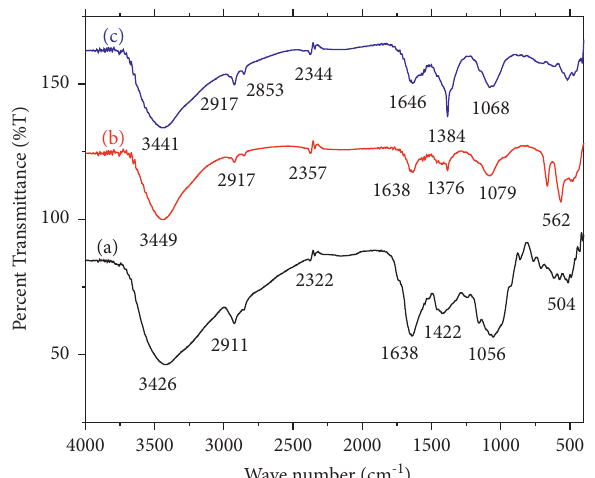
Figure 5: FTIR spectra of (a) calcined Co 3 O 4 (1:1) NPs, (b) uncalcined Co 3 O 4 (1 :1) NPs, and (c) Solanum tuberosum leaf extract.